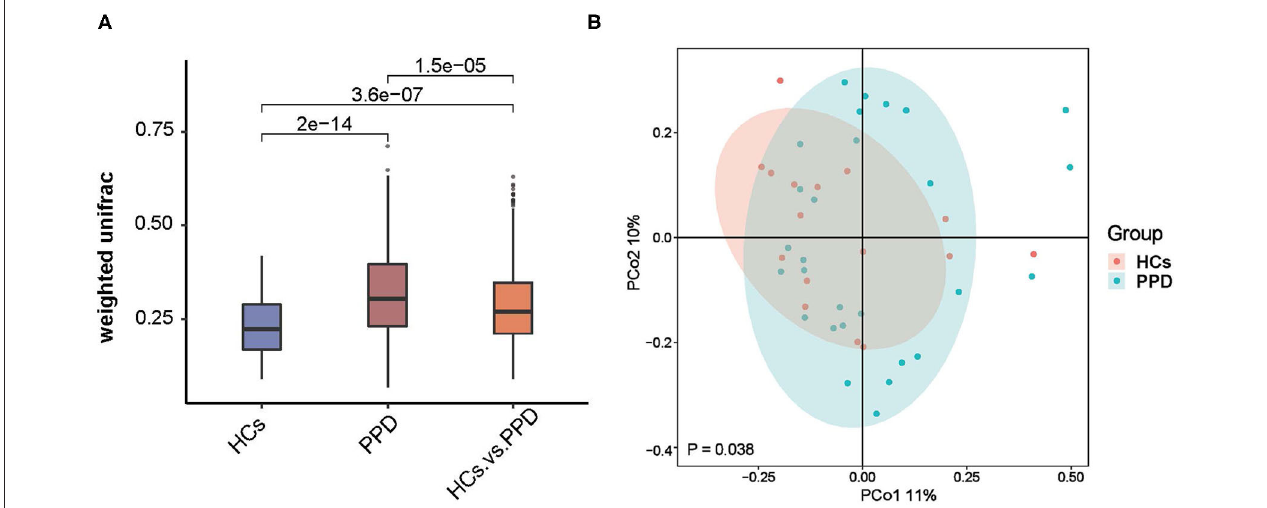
FIGURE 3 | An analysis of microbial β -diversity. The Wilcoxon rank-sum test analysis (A) and Principal coordinates analysis plots (B) of the fecal microbiome based on the weighted-UniFrac distance metric.